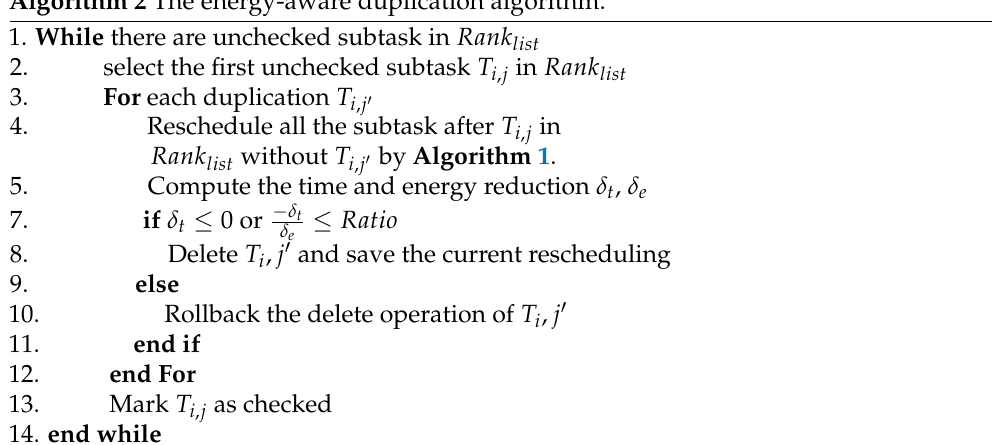
Algorithm 2 The energy-aware duplication